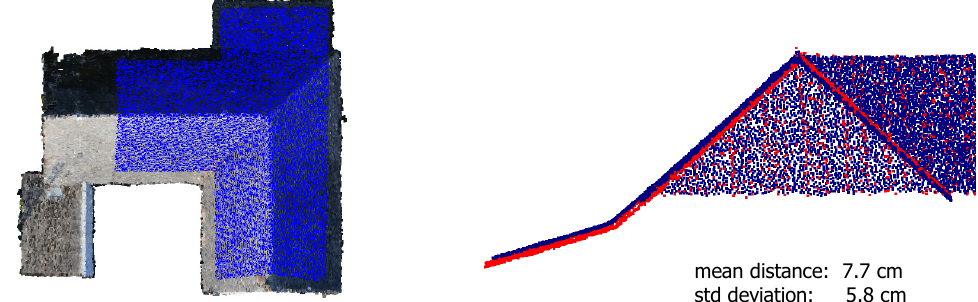
mean distance: 7.7 cm std